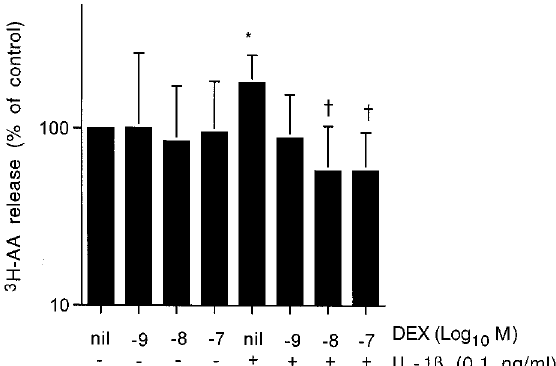
FIG. 3. Effect of DEX on human FLS PLA 2 activity. FLS were treated with DEX (10 -9 –10 -7 M), and/or IL-1 b (0.1ng/ml) for 8h. PLA 2 activity ( 3 H-AA released) is expressed as a per- centage of untreated FLS. Values are the mean ± SEM of 8 experiments. * p < 0.01 versus untreated FLS, p < 0.05 versus IL-1 b -treated FLS.